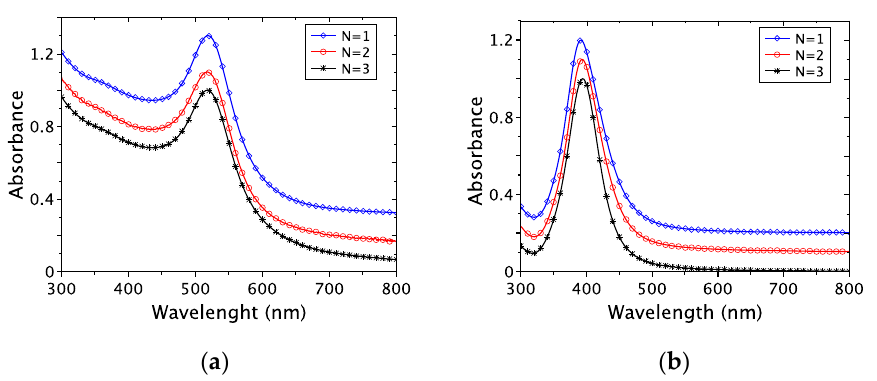
Figure 3. UV-visible spectra of ( a ) AuNPs and ( b ) AgNPs in water (for three independent experiments: N = 1 to 3). Stacked curves for more clarity.